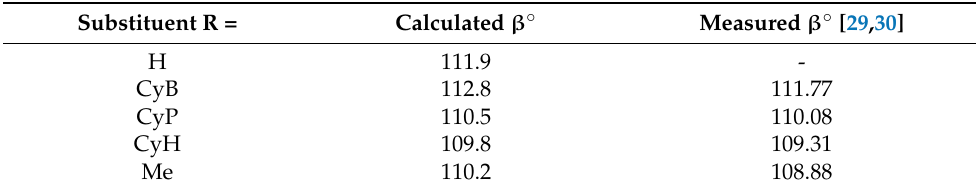
Table 4. A comparison of calculated and measured dihedral angles β ◦ for the different substituted glycoluril diethers shown in Figure 1. Substituent R